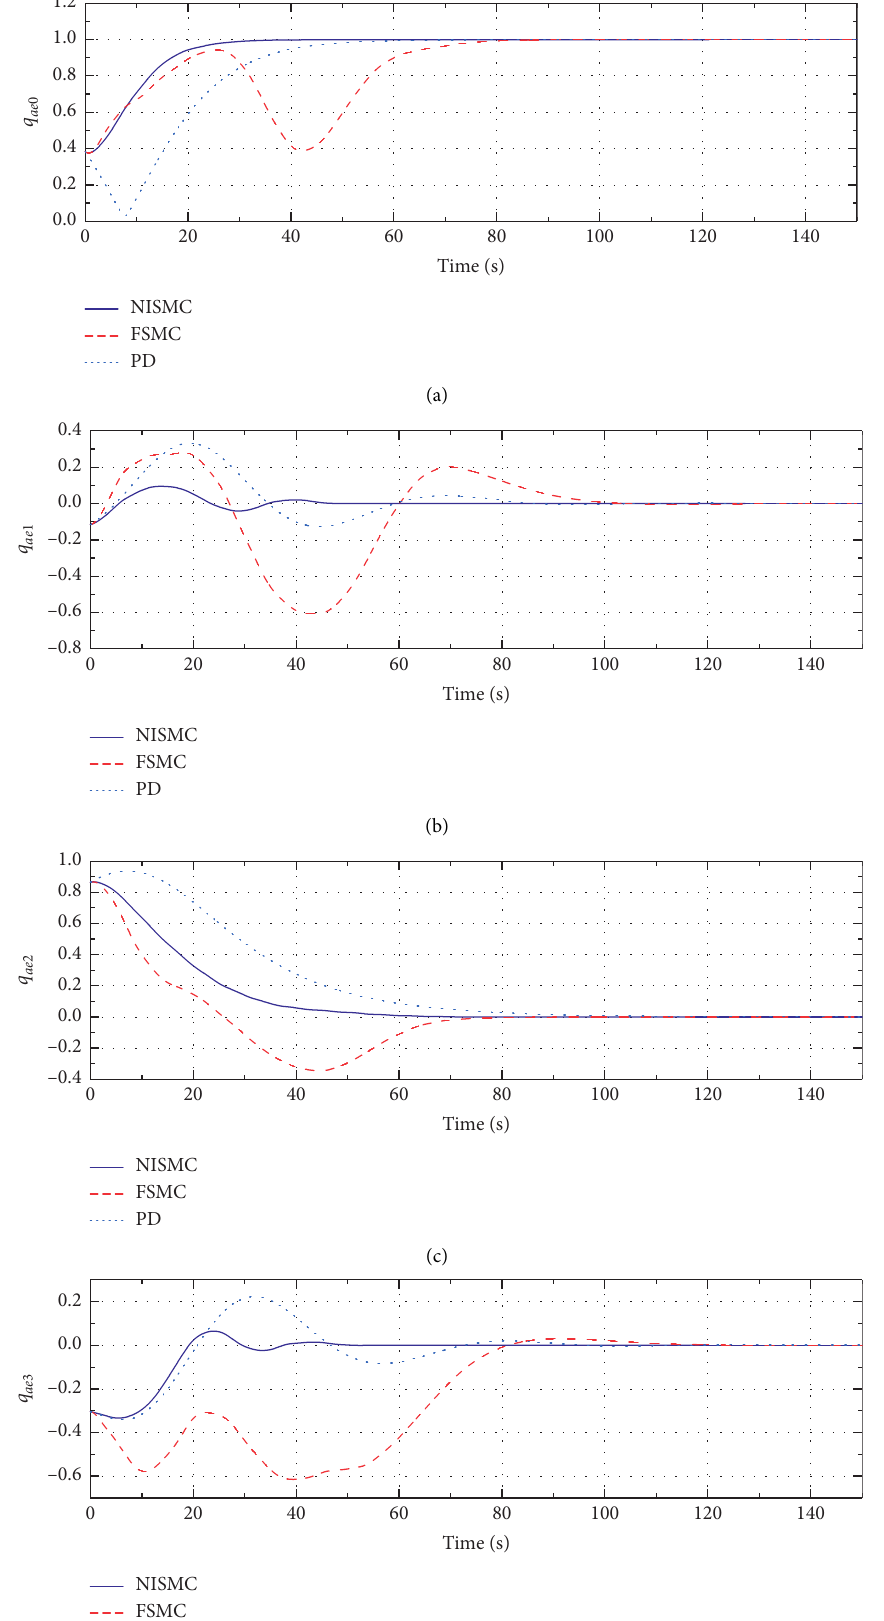
Figure 10: Comparison of error quaternions of flexible solar